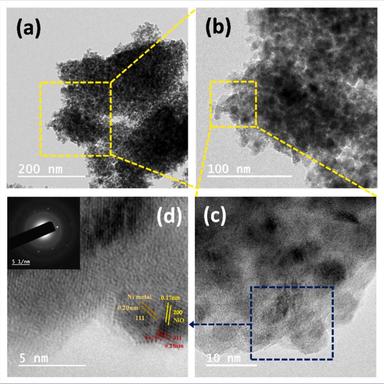
TEM image of Ni(15 %)-MRM at (a) 200 nm (b) 100 nm (c) 10 nm scale and (d) HRTEM at 5 nm scale (insert figure shows SAED pattern).